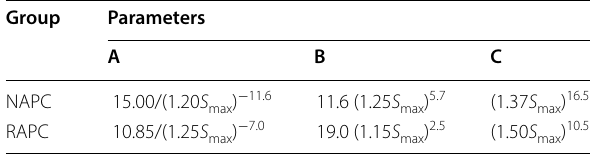
Table 9 Fitting curves of parameter A, B and